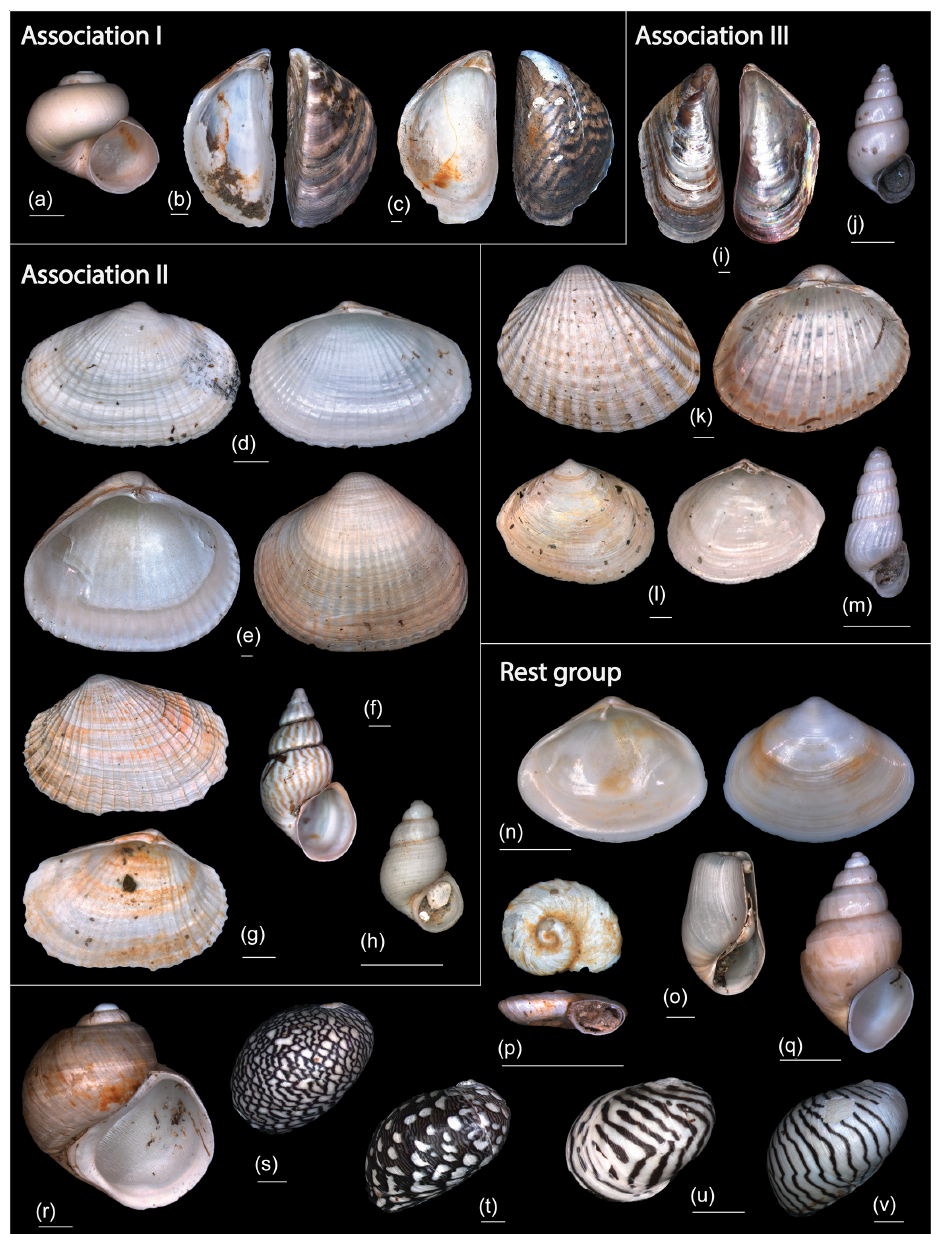
Figure 6. Overview of the 20 most abundant mollusc species grouped according to the results of Kendall’s W coefficient of concor- dance (for k = 4). (a) Valvata piscinalis (RGM.1309841, Core C7, depth 6cm). (b) Dreissena polymorpha (RGM.1309827, C7 –